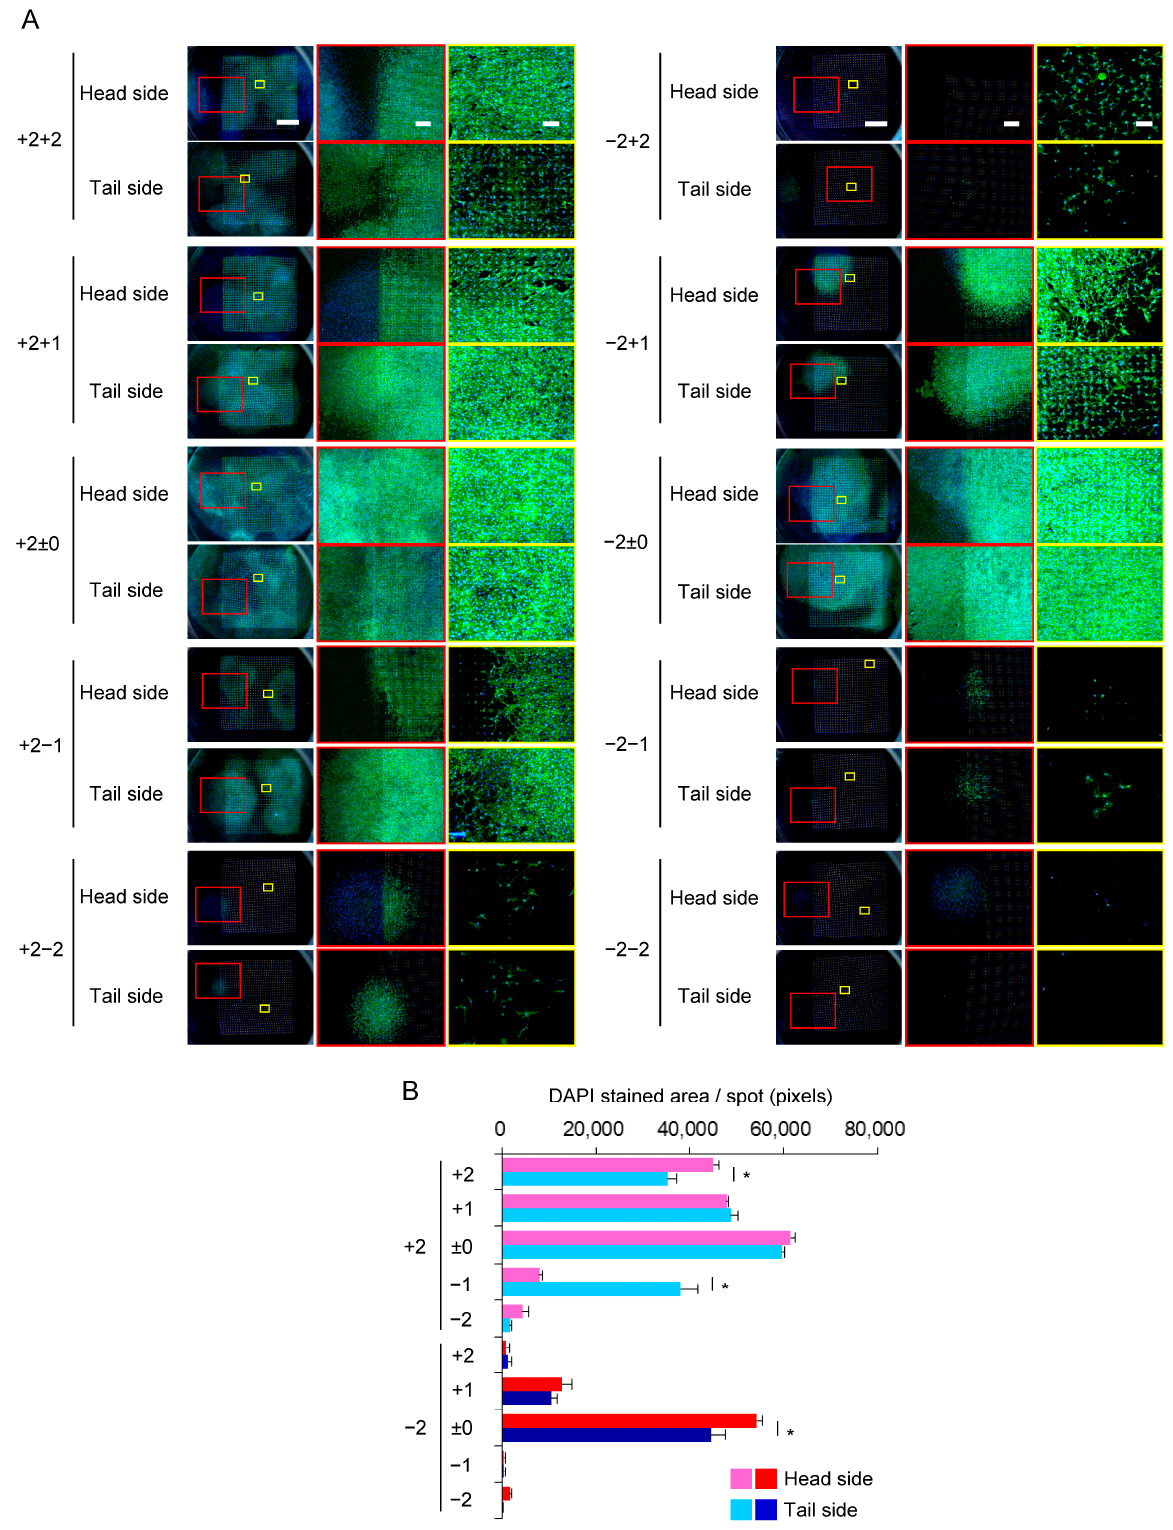
Figure 7. The expansion of C3H10T1/2 cells in multi-layered cultures: After the first multi-layered culture, the highest and lowest layers of membranes were separately placed between four new membranes and incubated for another 10 days (second multi-layered culture). The highest layer in the first multi-layered culture was defined as “+2 ± 0,” and the lowest layer was “ − 2 ± 0.” The